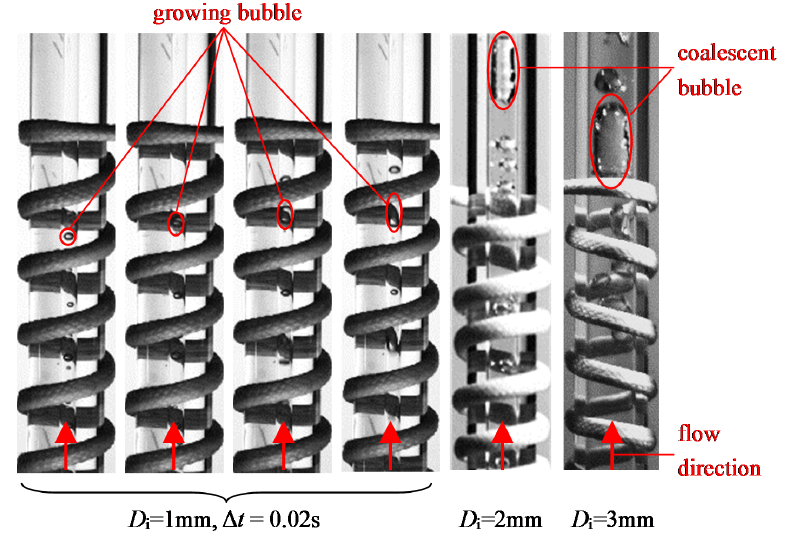
Figure 6. Evolution of flow pattern in the evaporators of the OHPs with different inner diameters ( Q ~ 100 W). ( Q ~100